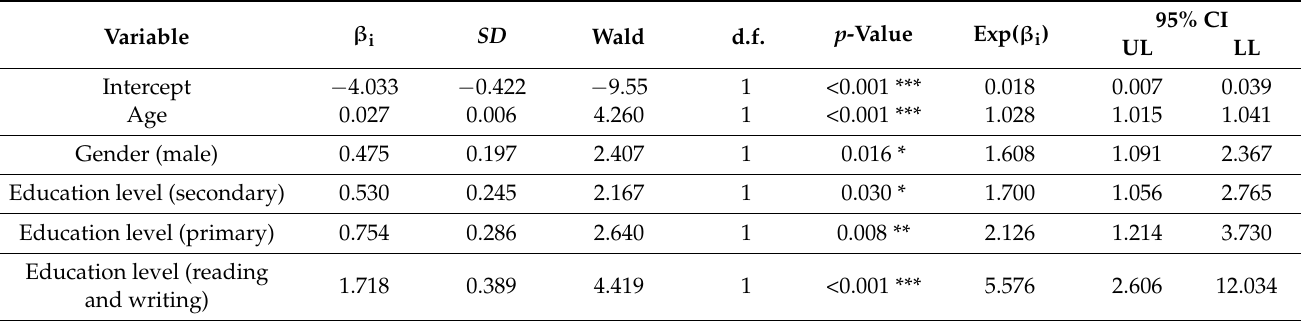
Table 4. Logistical regression model for difficulty in understanding a newly prescribed treatment adjusted for age, gender, and education